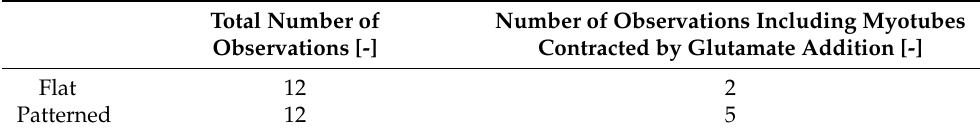
Figure 4. Co-culture of human SkM cells and MNs. ( A ) Immunofluorescent staining of co-culture on the linearly patterned surface. Green indicates AChR clustering, red indicates axon, and blue indicates MyHC. NMJs are surrounded by a dashed square, and a magnified view of this region is shown. Scale bar: 100 µm. ( B ) Representative contractile displacement of Hu5/KD3 myotubes co- cultured with iPSC-derived MNs on the patterned surface. ( i ) Before. ( ii ) After addition of glutamate (Glu). ( iii ) After addition of Glu and tetrodotoxin (TTX). Table 2. Comparison of the number of functional NMJ observed in co-culture models of human SkM myotubes and human iPSC-derived MNs. Total Number of Number of Observations Including Myotubes Observations [-] Contracted by Glutamate Addition [-] Flat 12 2 Patterned 12